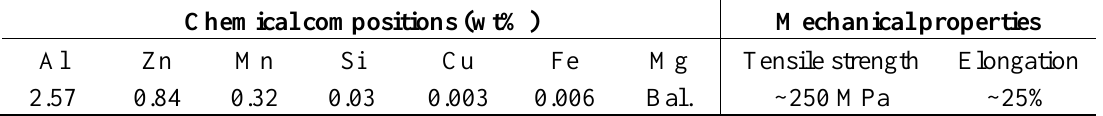
Table 2. Chemical compositions (mass fraction, %) and mechanical properties of AZ31 alloy. Chemical compositions